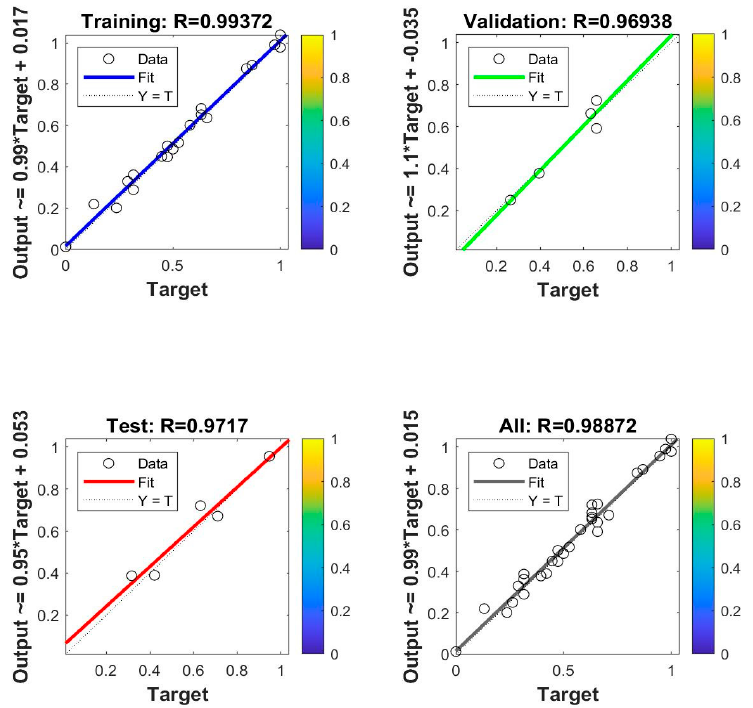
Figure 4. Training, validation, and test results.